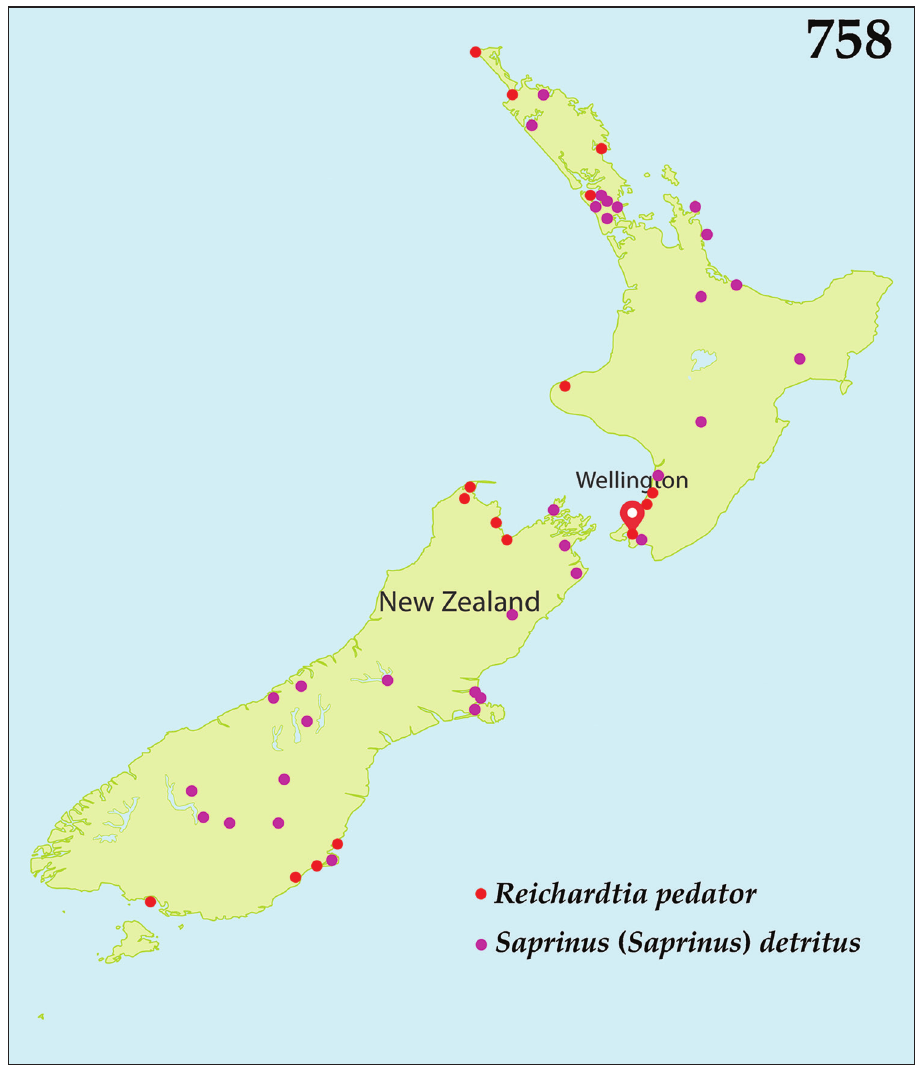
Figure 758. Distribution of Reichardtia pedator (Sharp, 1876) and Saprinus ( Saprinus ) detritus (Fabricius, 1775) in mainland New